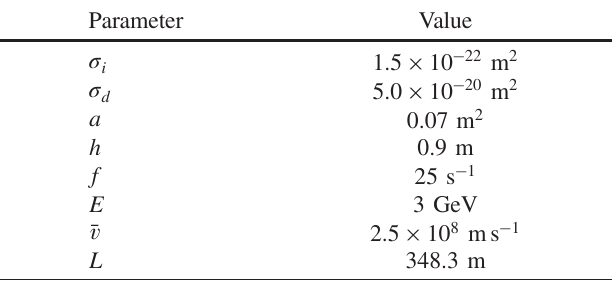
TABLE III. Values of the fixed parameters in the calculation.